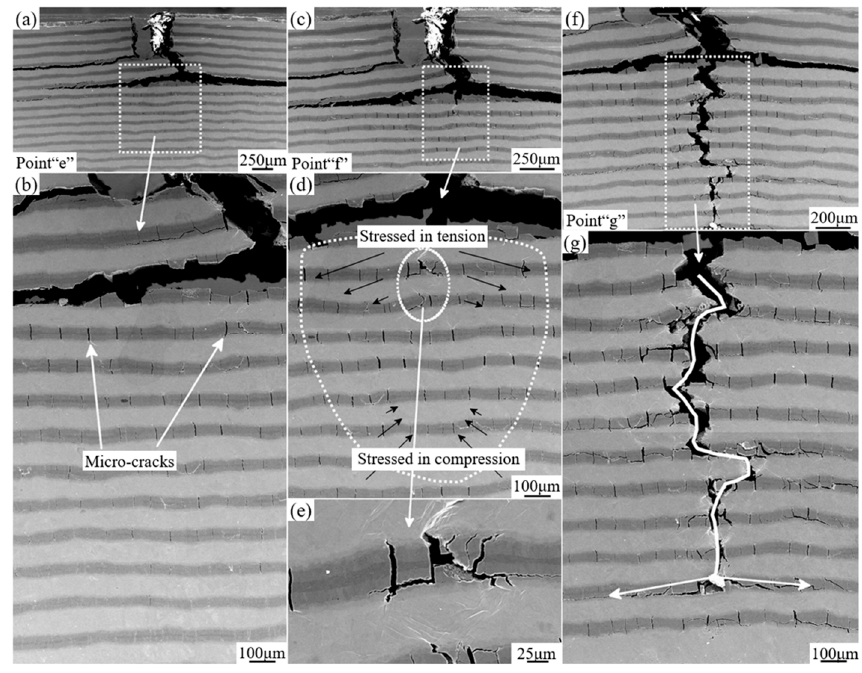
Figure 8. SEM micrographs of the in-situ three-point bending test corresponding to the second part of the Load-displacement curve representing the cracks propagation process and the final morphologies of the specimen after catastrophic fracture : ( a ) and ( b ) represents the detailed deformation morphologies of the specimen corresponding to the ”Point e” in Figure 6, showing lots of micro-cracks formed before the novel main crack exposure; ( c ) , ( d ) , and ( e ) correspond to “Point f” in Figure 6, showing the distribution of micro-cracks with the mushroom shape; ( f ) and ( g ) correspond to “Point g” in Figure 6, showing the “zigzag” propagation of the main crack